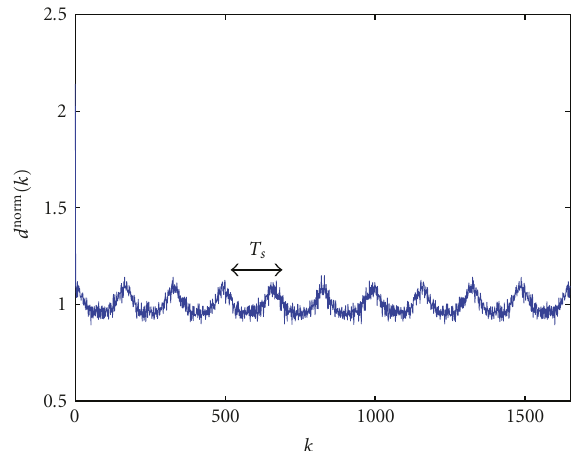
Figure 5: Power autocorrelation of a ZP-OFDM signal on a CM-4 channel model with SNR =